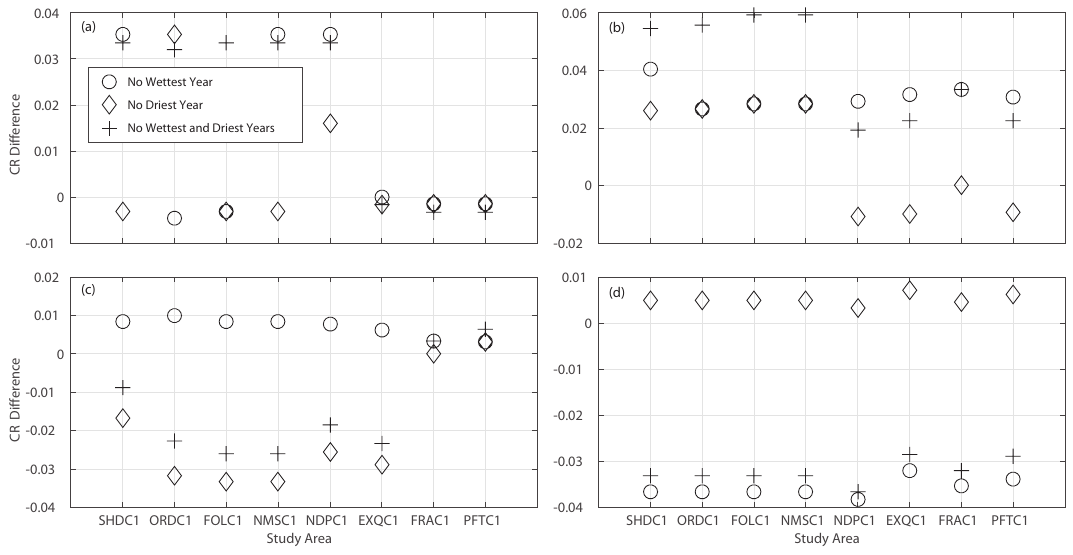
Figure 10. Differences in median daily containing ratios of ( a ) maximum and minimum forecasts; ( b ) forecasts with 10% and 90% exceedance probabilities; ( c ) minimum forecast and forecast with 90% exceedance probability and ( d ) forecast with 10% exceedance probability and maximum forecast between the scenarios with the wettest year, driest year, wettest and driest years unconsidered and the scenario with all years